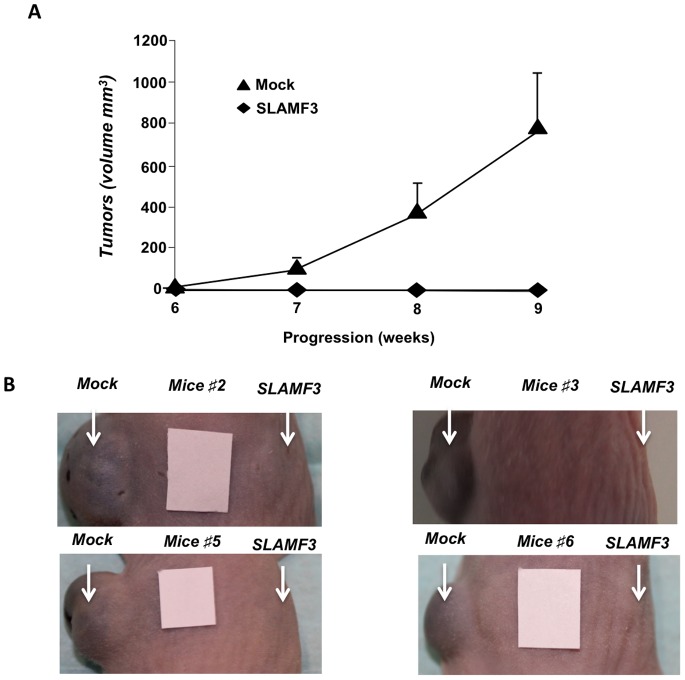
The effect of SLAMF3 expression on the growth of HCC xenografts in nude mice.(A) Tumour volumes were measured 6, 7, 8 and 9 weeks after injection in nude mice. Four out of ten animals developed a tumour on the left flank (after injection of mock-transfected Huh7 cells) but none of the ten developed a tumour on the right flank (after injection of SLAMF3-overexpressing Huh7 cells) and represented as mean ± SD (*p<0.05); (B) photographs of tumour progression on left flanks (mock-transfected Huh7 cells) and right flanks (SLAMF3-overexpressing Huh7 cells) (mice #2, #3, #5 and #6).